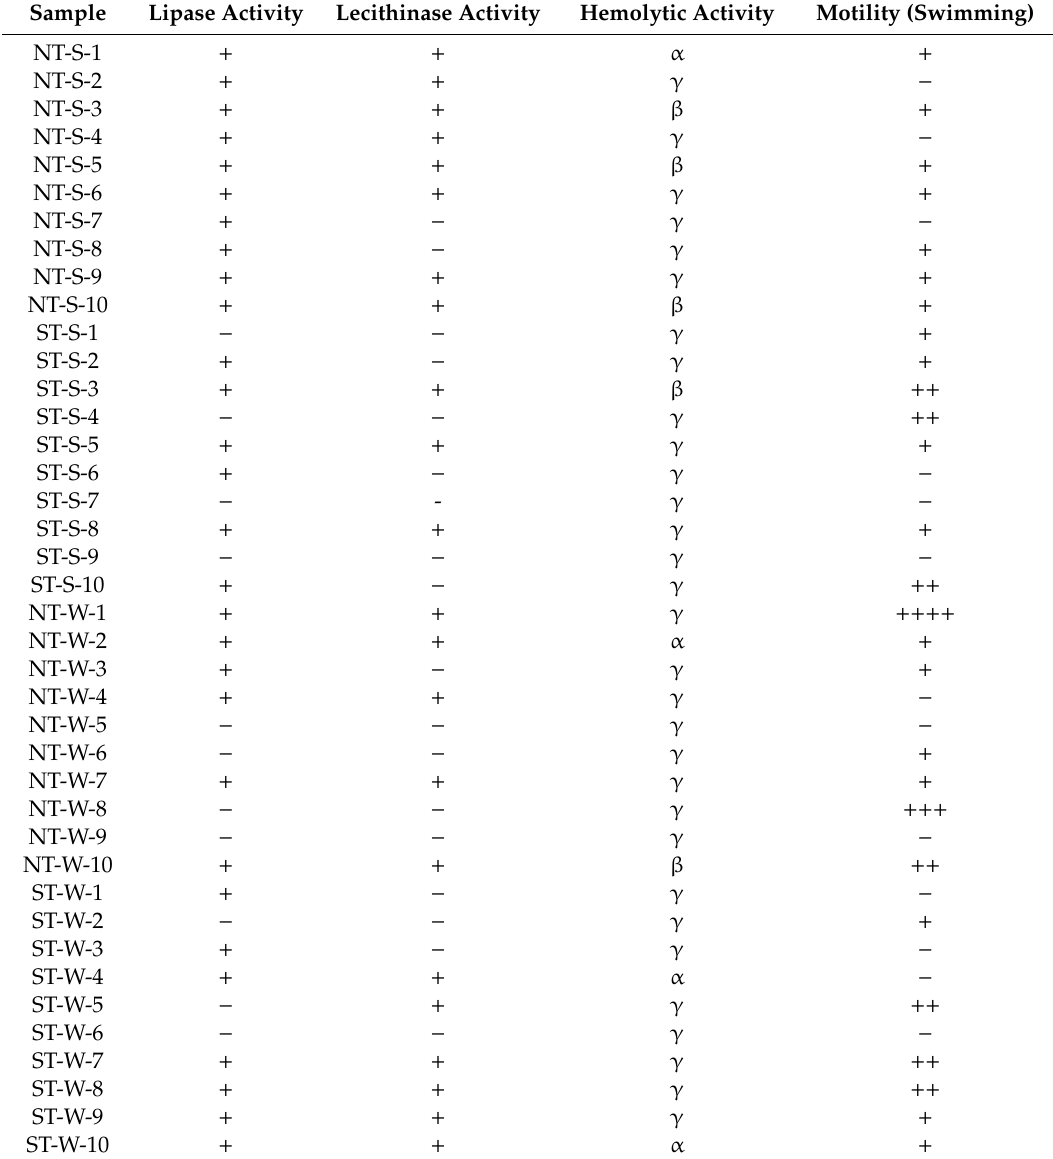
Table 1. Phenotypic characteristic (lipase activity, lecithinase activity and haemolytic activity; − negative; + positive) and swimming motility ( − negative; + positive; ++ moderately positive; +++ medium positive; ++++ strong positive) of isolates from wastewater treatment plant after 24-h incubation at 30 ◦